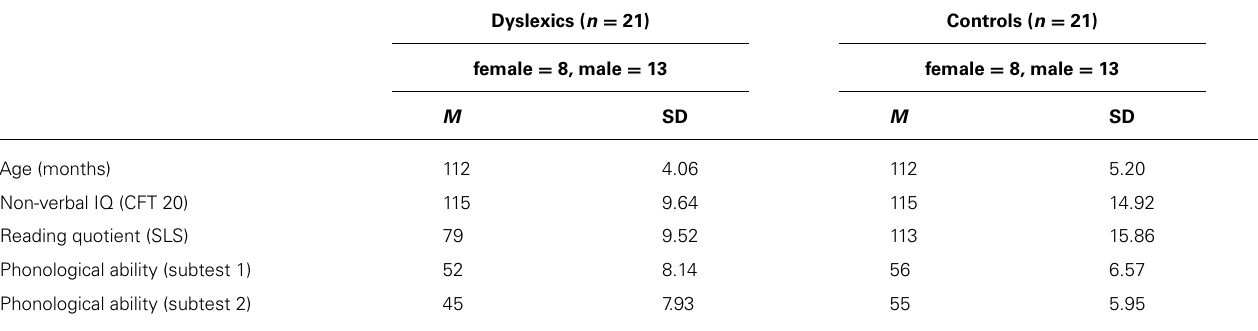
Table 1 | Participant characteristics as a function of